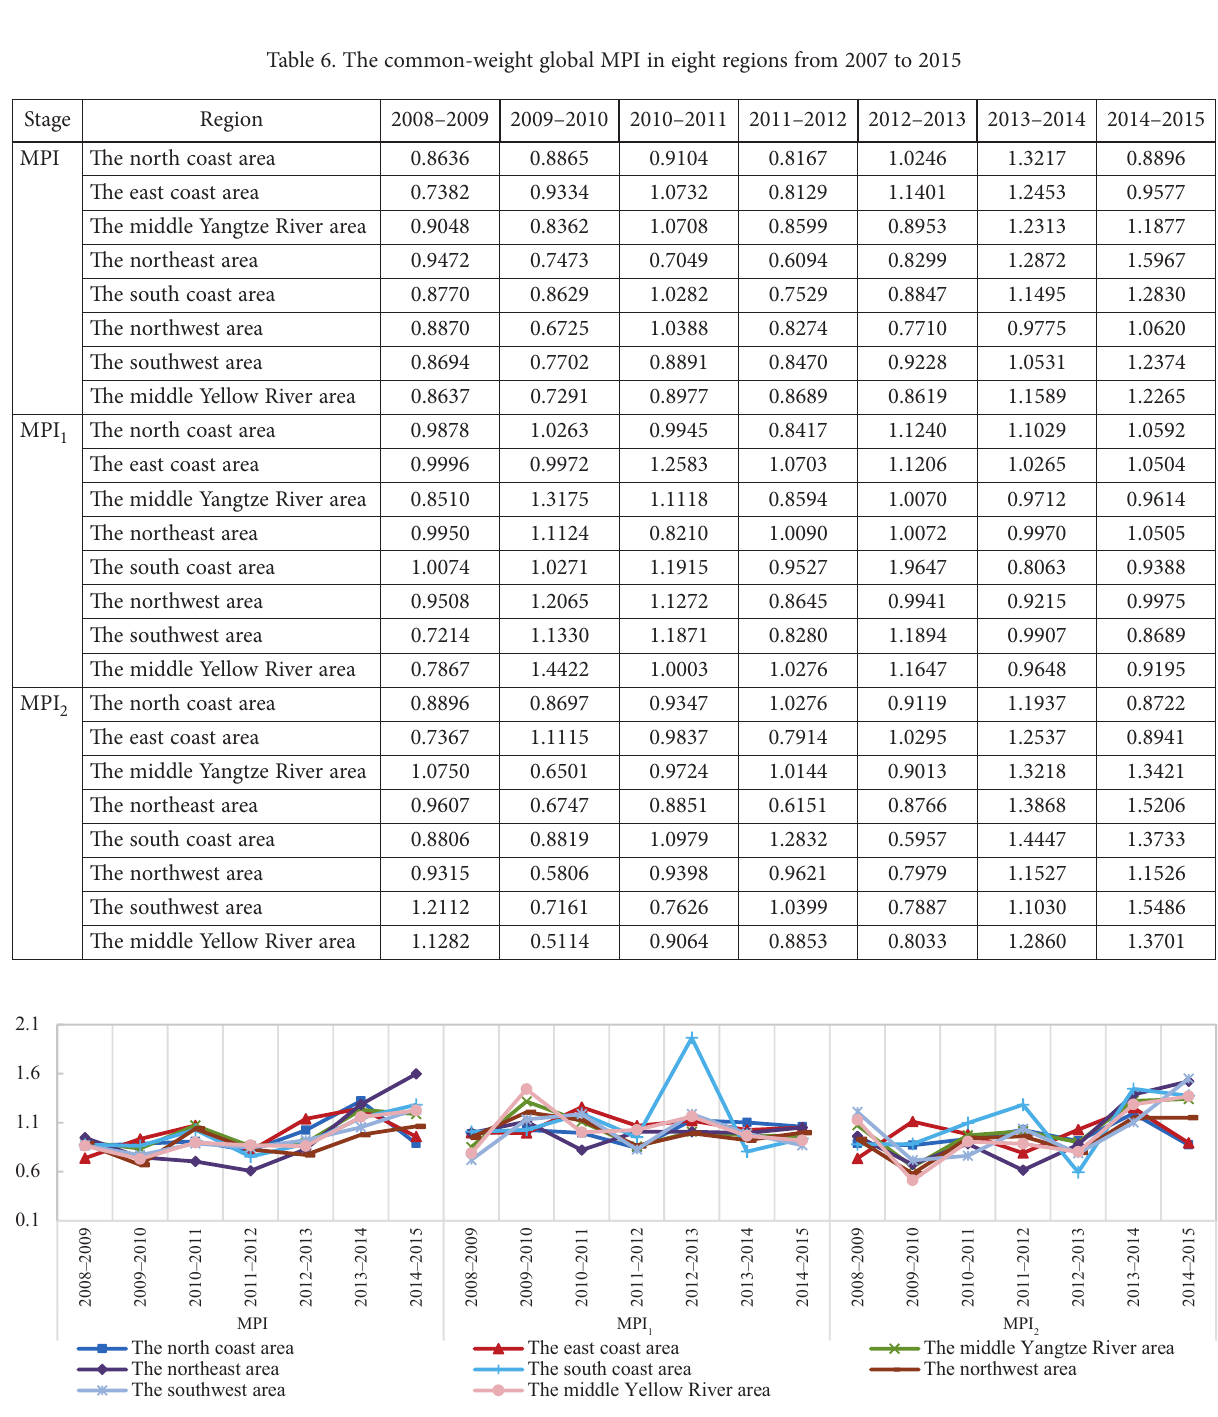
Figure 9. The line graph of the average common-weight global MPI and its